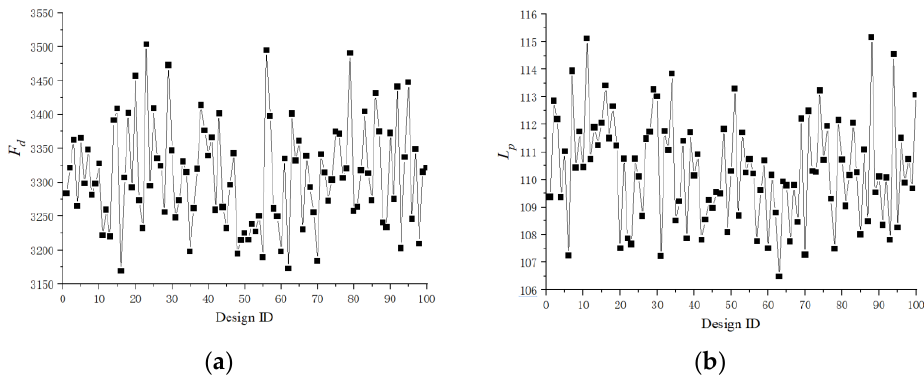
Figure 5. Output variables at each design point: ( a ) Aerodynamic resistance, ( b ) Dipole noise source